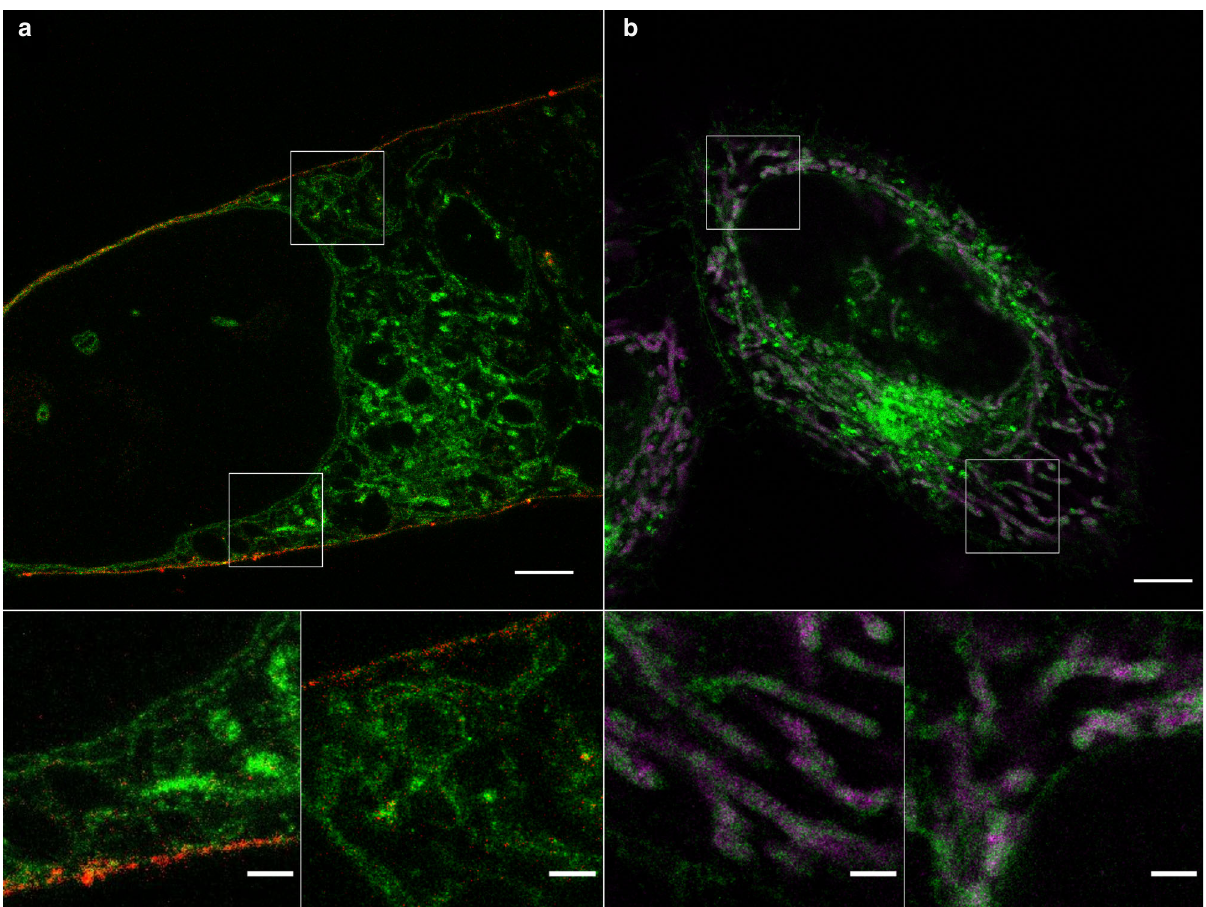
Fig. 2 Sphingolipid ExM enables super-resolution imaging of cellular membranes and protein interactions. a Confocal fl uorescence image of a 10x expanded HeLa229 cell fed with ATTO643-mCling (red) and α -NH 2 - ω -N 3 -C 6 -ceramide clicked with DBCO-Alexa Fluor 488 (green). Scale bars, 20 µ m. The images at the bottom show magni fi ed views of the regions outlined by the white boxes in the main images. b Confocal fl uorescence image of 4x expanded HeLa229 cells. Cells were fed with α -NH 2 - ω -N 3 -C 6 -ceramide, fi xed, permeabilized, and labeled with DBCO-Alexa Fluor 488 (green). In addition, Prx3 (magenta), which is located in the mitochondrial matrix was stained by immunolabeling using ATTO 647 N labeled secondary antibodies. The data were obtained from n = 3 independent experiments. Scale bars, 5 µ